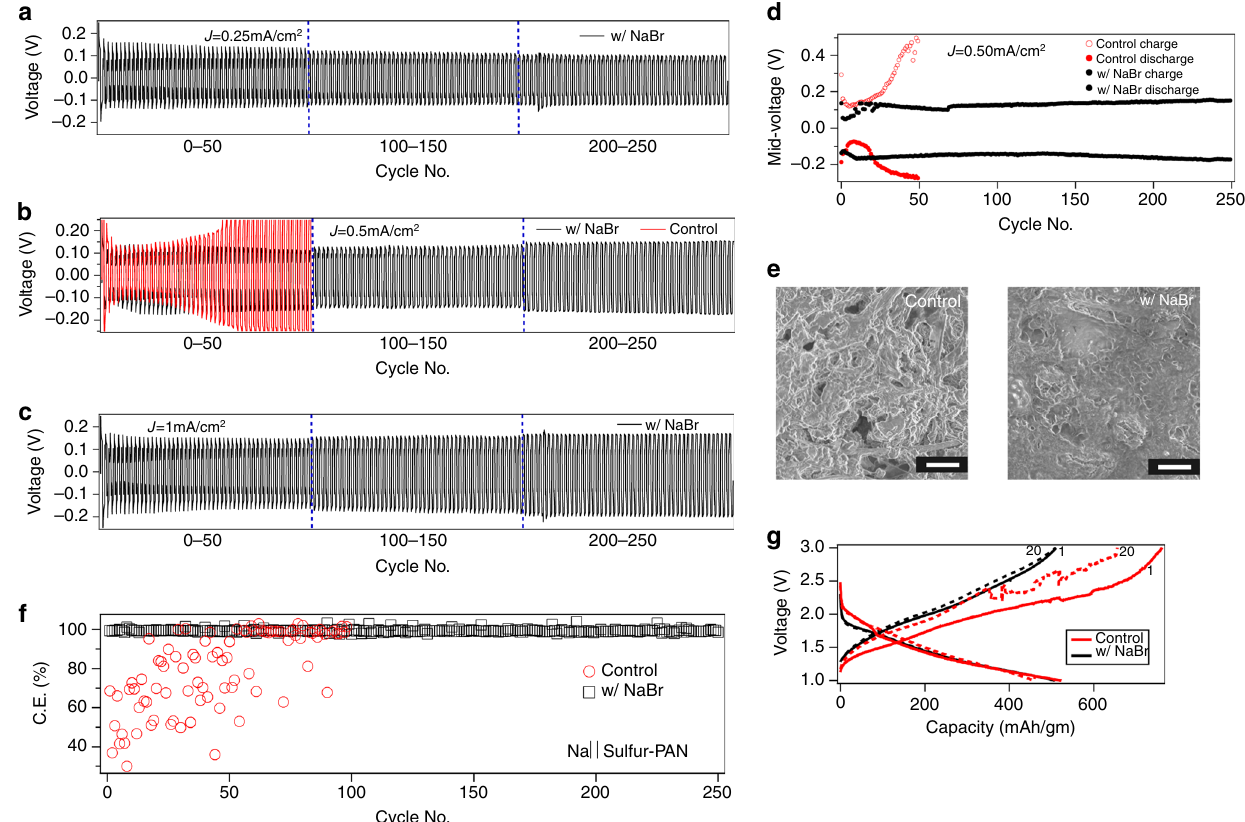
Fig. 6 Galvanostatic cycling performance of Na anodes. Voltage pro fi le obtained by consecutively charging and discharging a symmetric sodium cell at current densities of a 0.25 mA cm − 2 , b 0.5 mA cm − 2 , c 1 mA cm − 2 . In each experiment, one complete cycle was 1 h long, with each charge and discharge time is half-an-hour. The pro fi les in black represent sodium metals with NaBr coating and red stands for pristine sodium (control). d The voltage hysteresis represented by the mid-voltage values of charge and discharge is plotted as a function of cycle no. for NaBr coated and control sodium cells corresponding to ( b ). e Morphology of sodium metal electrode obtained from post-mortem SEM analysis. The cells were charged at a rate of 1 mA cm − 2 for 2 h before being taken apart for the post-mortem analysis. The left image are results for pristine Na, while the image to the right is for NaBr-coated Na; for both images: scale bar , 5 µ m. f Coulombic ef fi ciency of a Na || Sulfur-PAN composite half-cell as a function of cycle number. g Voltage pro fi le of Na || Sulfur-PAN during charging and discharging at the 1st and 20th cycle numbers. The red lines / symbols represent control, while black shows the result for